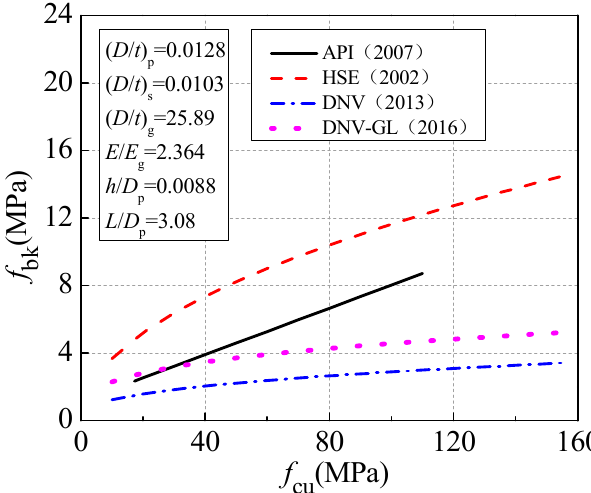
Figure 5. Relationship between interface shear strength ( f bk ) and grouted material strength ( f cu ).